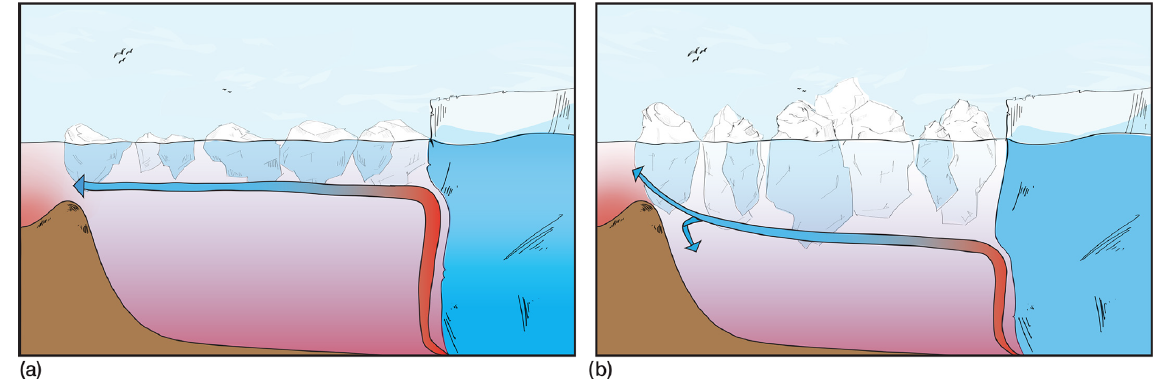
Figure 11. Illustration of iceberg modification of the plume and GMW outflow. Icebergs depress the neutral buoyancy depth of the plume and the subsequent GMW outflow. The GMW outflow is further modified by icebergs and mixes partially back into the fjord when reaching a high